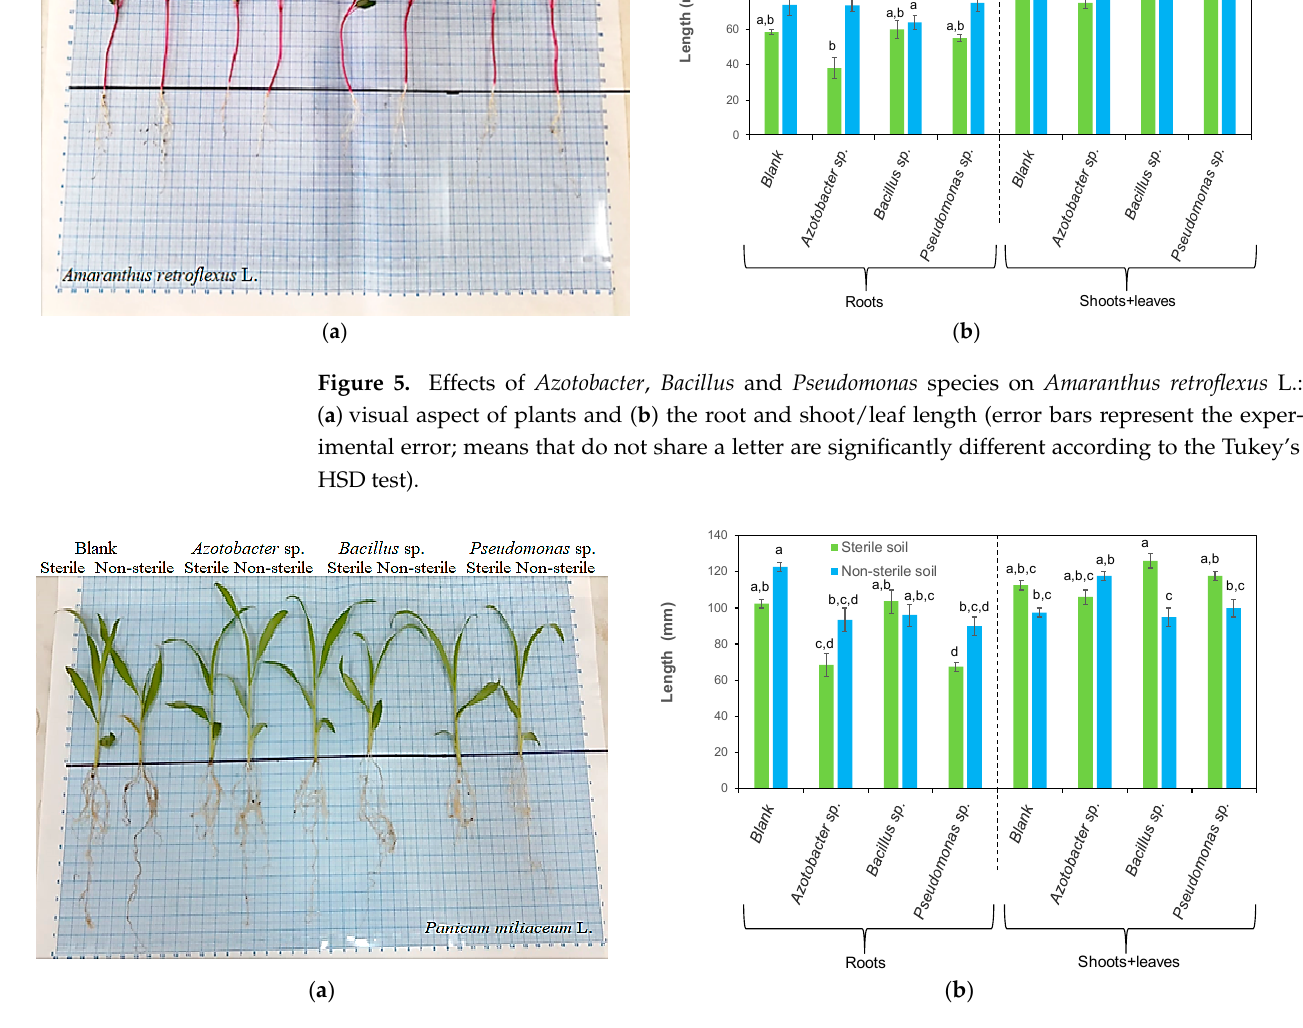
Figure 5. Effects of Azotobacter , Bacillus and Pseudomonas species on Amaranthus retroflexus L.: ( a ) visual aspect of plants and ( b ) the root and shoot/leaf length (error bars represent the experi- mental error; means that do not share a letter are significantly different according to the Tukey’s HSD test).